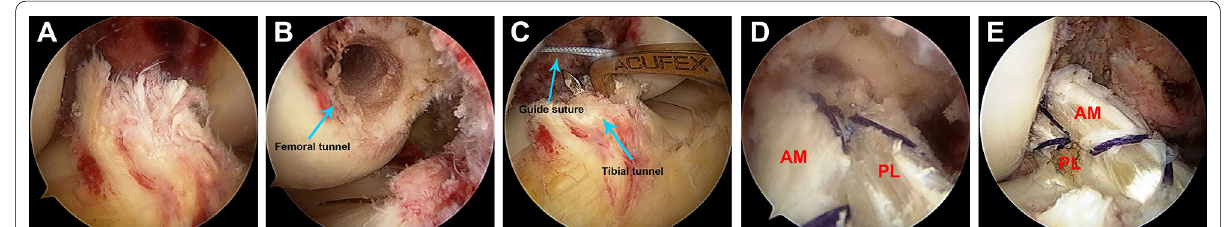
Fig. 3 Surgical procedures for STDB ACL reconstruction under arthroscopy. A Diagnosis of ACL rupture under arthroscopy. B Femoral tunnel. C Tibial tunnel. D Grafts were pulled into the femoral tunnel. E Reconstructed